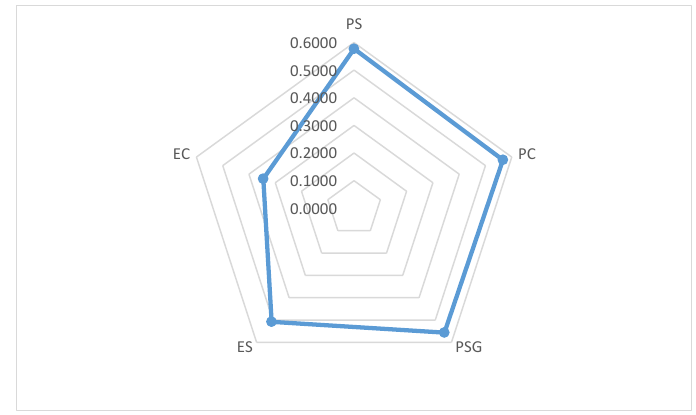
Figure 4. Comparison of systems by potential environmental impacts of the tree growing phase.